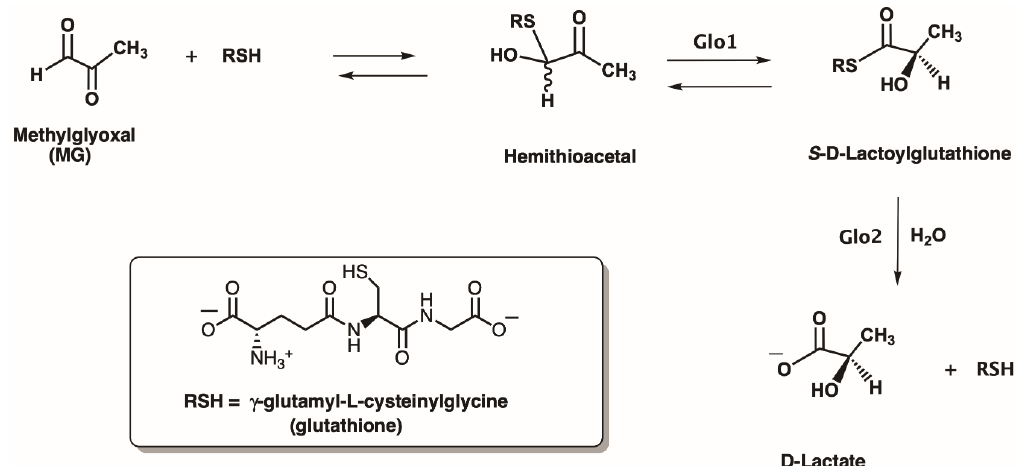
Figure 1. The overall reaction of the enzymes glyoxalase I (Glo1) and glyoxalase II (Glo2). The intracellular thiol utilized in many, but not all, organisms is the tripeptide glutathione.